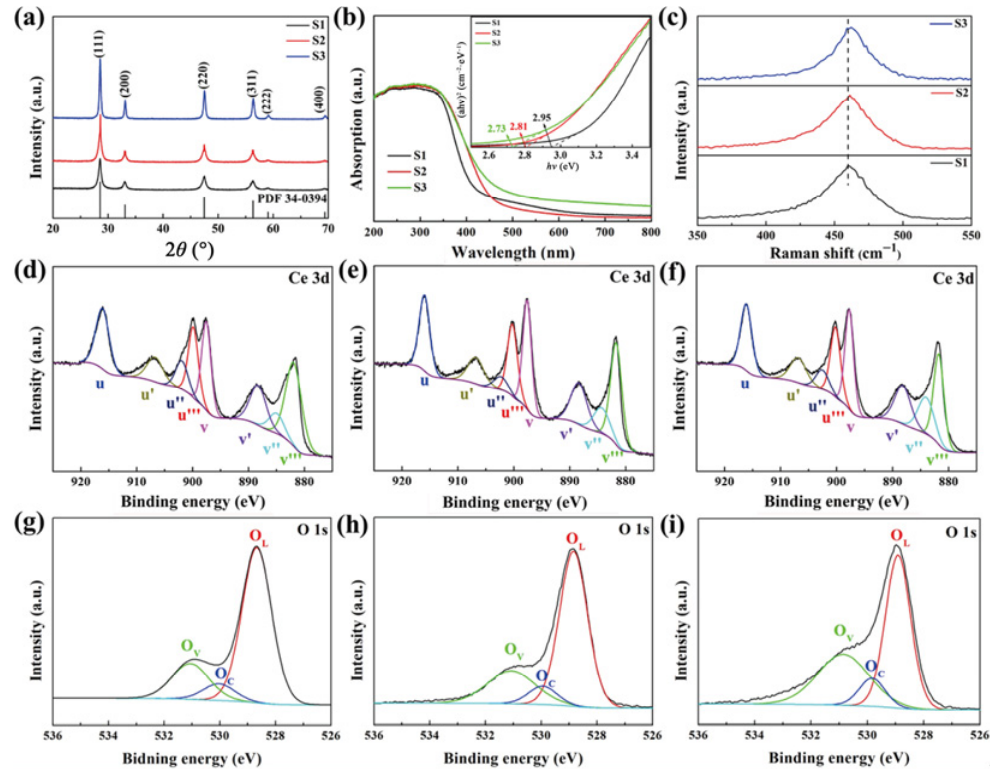
Fig. 3 (a) XRD patterns; (b) UV–Vis absorption spectra (the inset shows the corresponding Tauc spectra); (c) Raman spectra of S1, S2, and S3; and XPS analysis of Ce 3d and O 1s spectra for (d, g) S1, (e, h) S2, and (f, i)